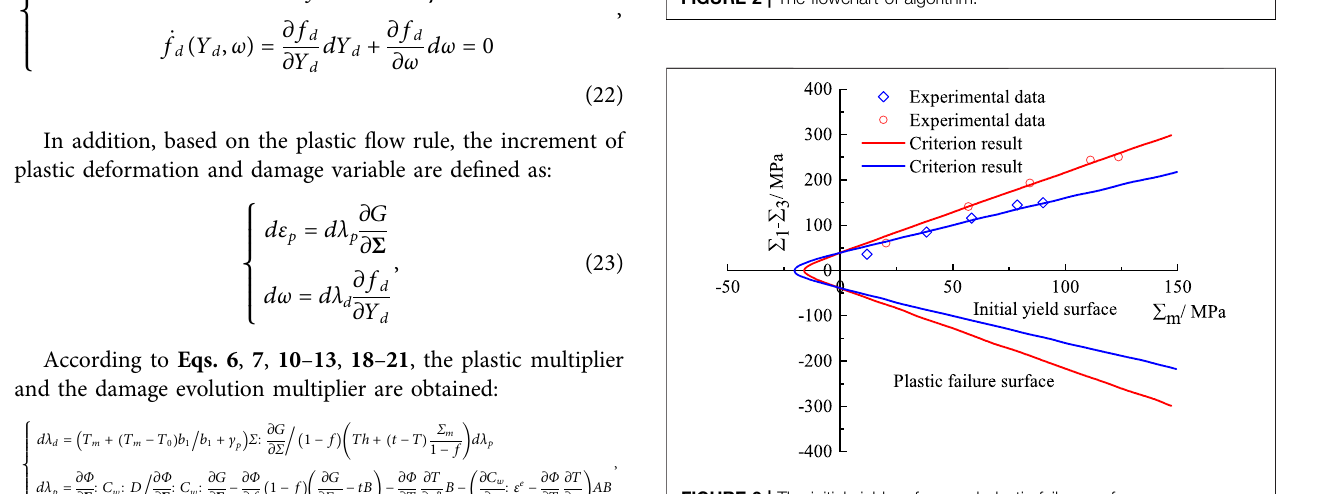
FIGURE 2 | The fl owchart of algorithm.